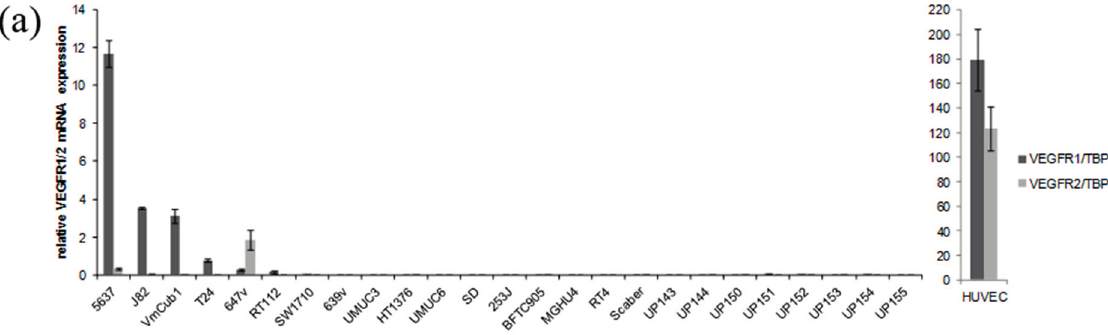
Figure 1. mRNA expression profiles of receptor tyrosine kinases. ( a ) Vascular endothelial growth factor receptor 1 (VEGFR1) and VEGFR2; ( b ) Platelet-derived growth factor receptor α (PDGFR α ) and PDGFR β ; and ( c ) cKIT in bladder cancer cell lines, normal urothelial cells and the positive controls HUVEC ( a ), VHF1 ( b ), HEK293 ( c ). All values were measured by quantitative RT-PCR (qRT-PCR) and values were adjusted to TBP mRNA. Mean values of two independent measurements and according standard deviation are